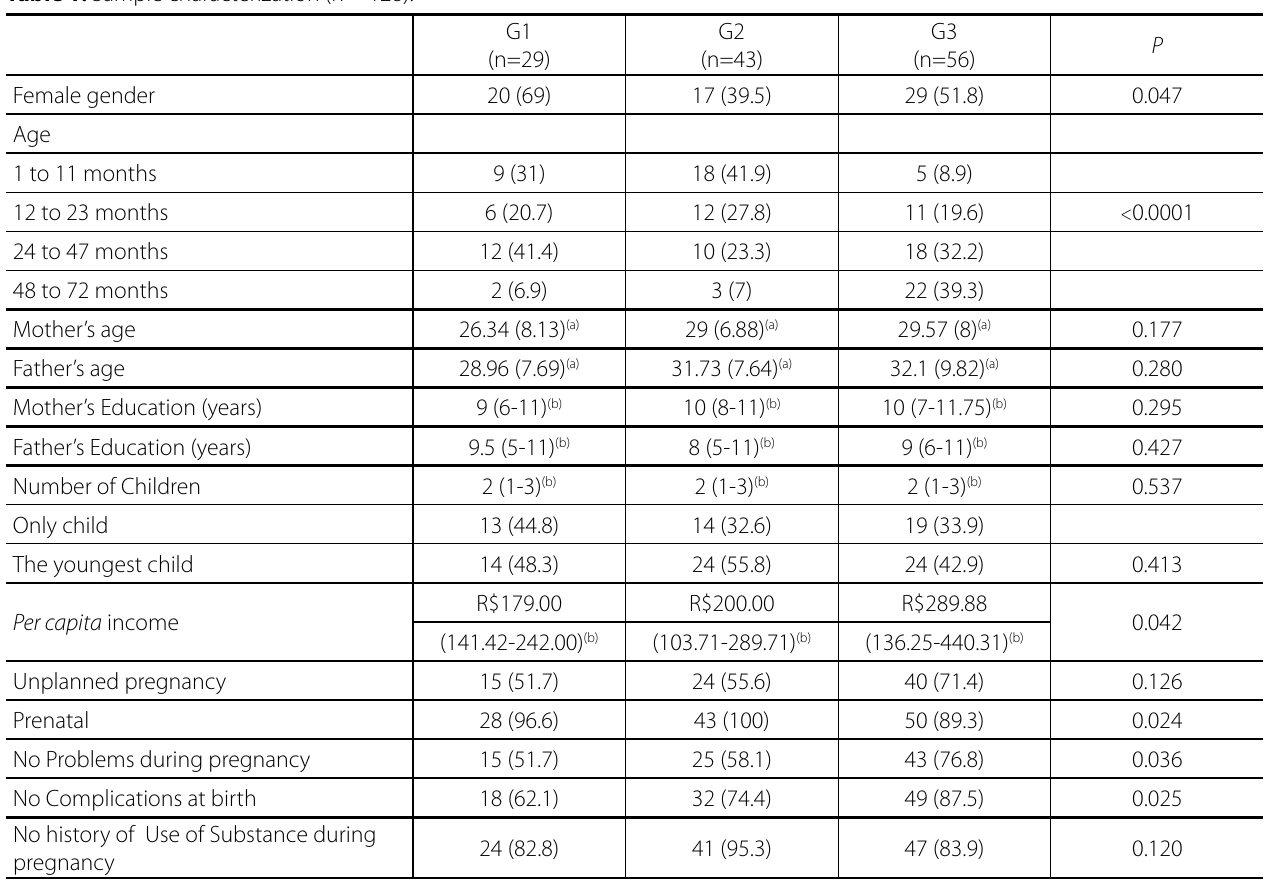
Table 1. Sample characterization (n =